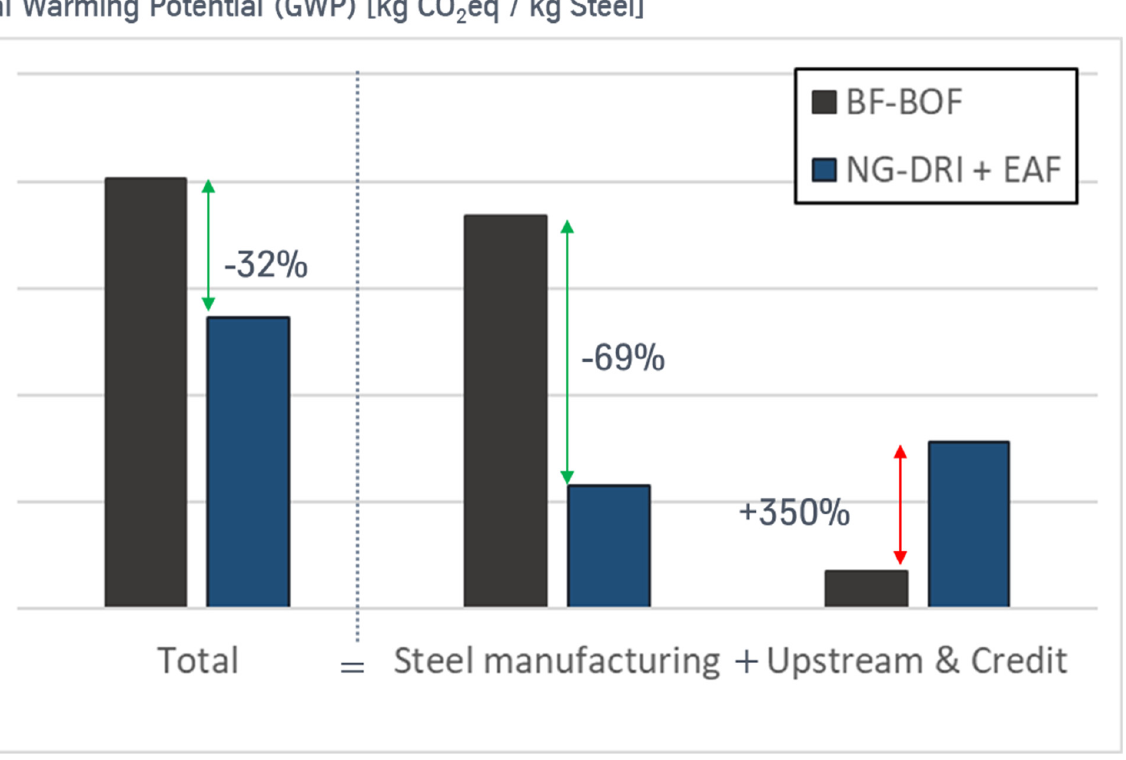
Figure 6. Global warming potential (GWP) of steel. Comparison of production using the blast fur- nace-basic oxygen furnace (BF-BOF) route with production using the direct reduction-electric arc furnace (DR-EAF) route.